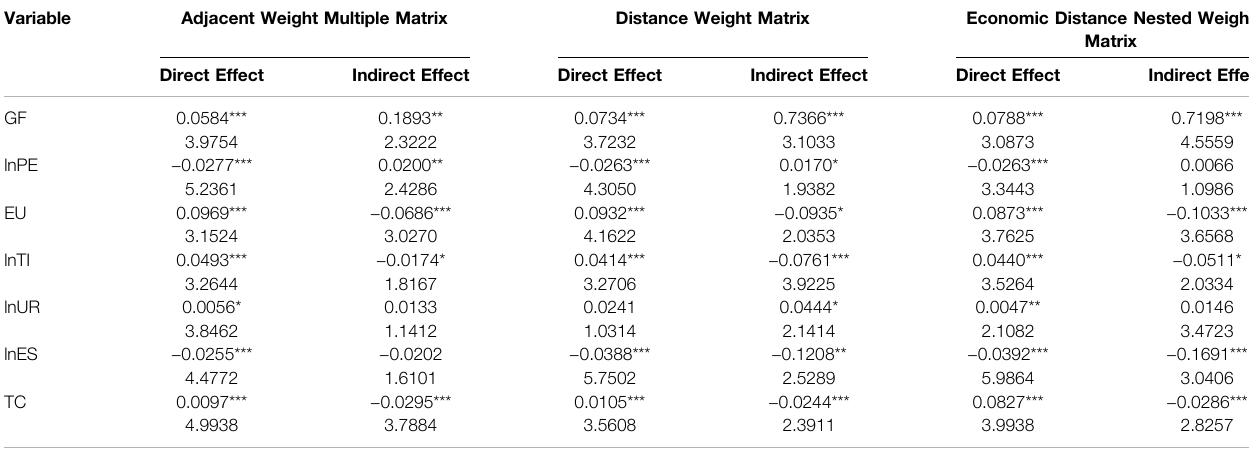
TABLE 5 | Decomposition of the effects of green fi nance on economic ecological development.